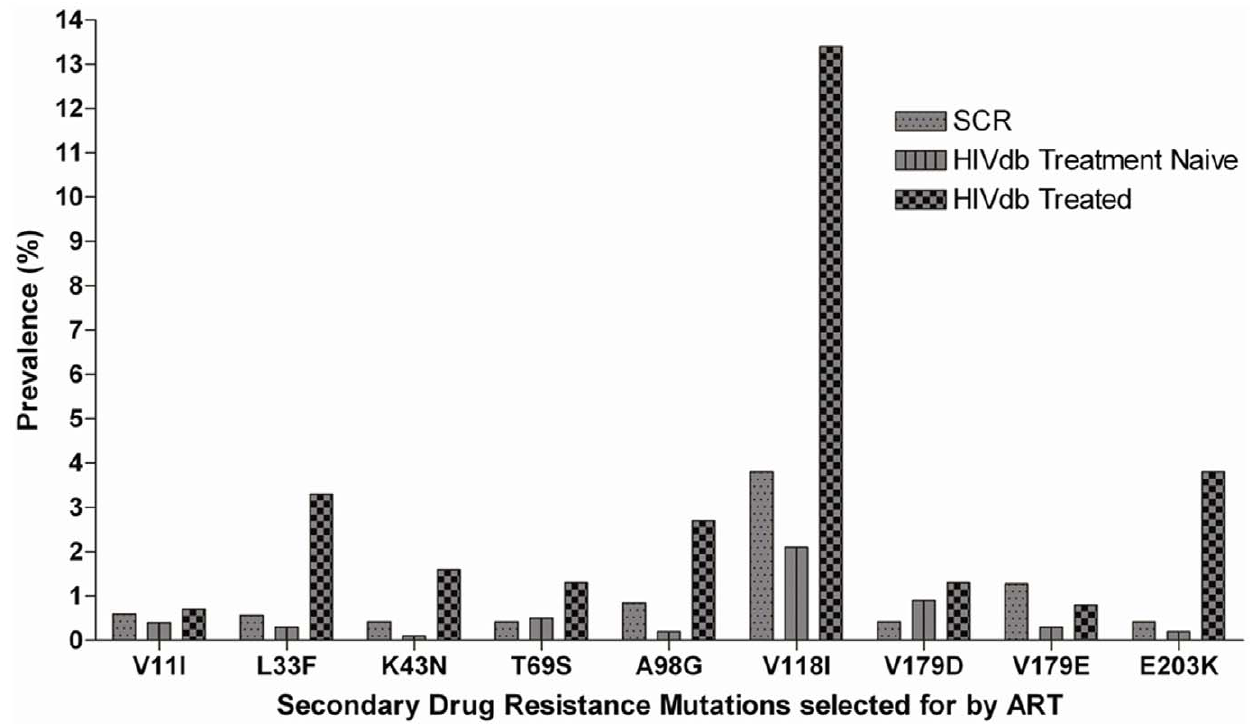
Figure 1. Secondary drug resistance mutation found in the study population Subtype C Drug Resistance (SCR) compared with data from treated and treatment naı¨ve patients in the HIVDB.